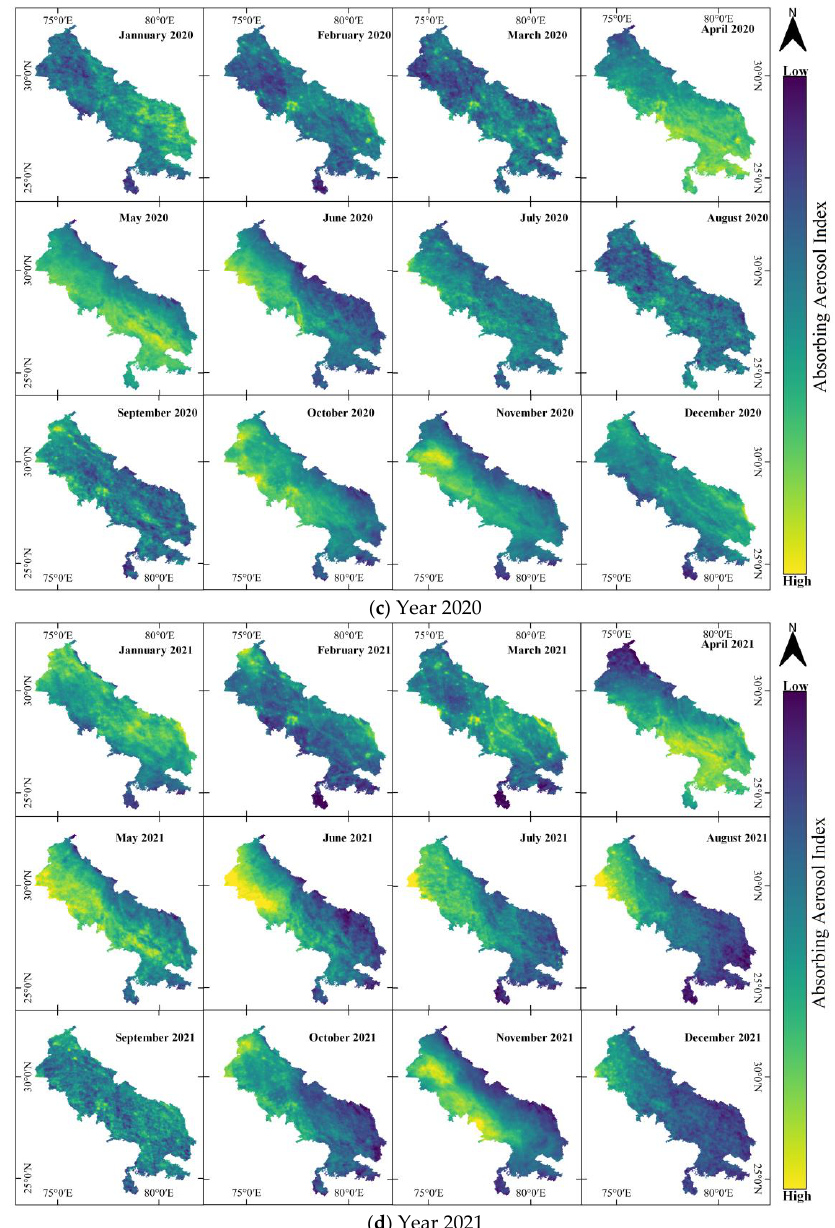
Figure 5. Atmospheric Aerosol Index concentration over the study site (July 2018 to December